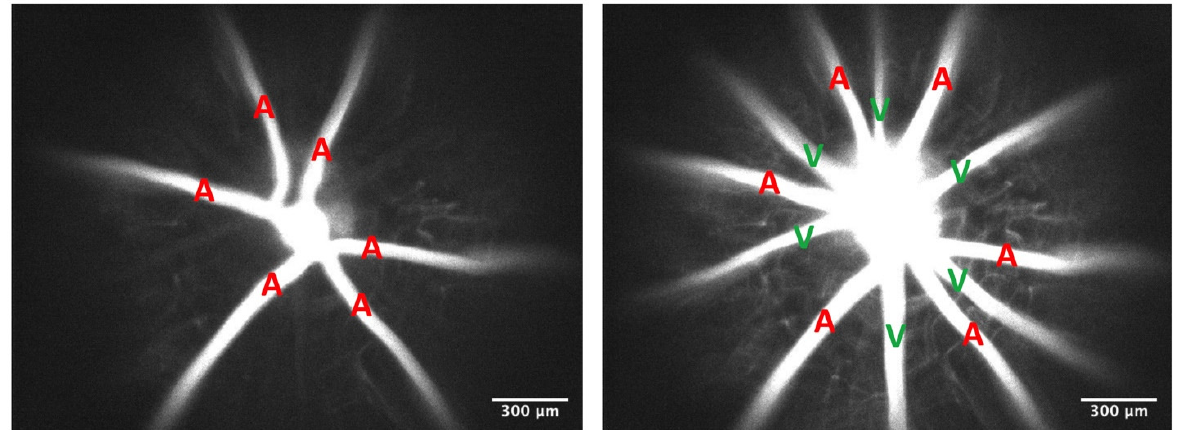
Figure 1. Filling of FITC–dextran in the Retinal Circulation following Infusion. The vessels filling first with infused FITC–dextran are arterioles (A) and the vessels filling later are venules (V). Scale bar = 300 μ m.